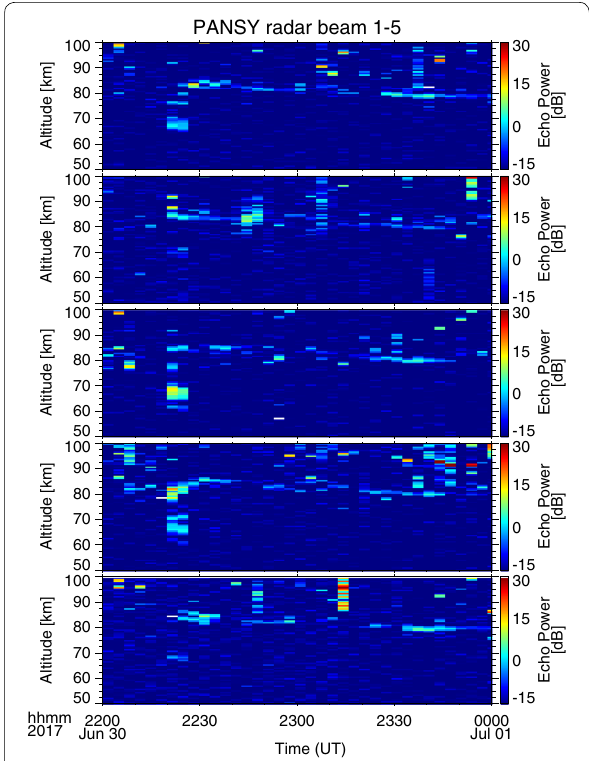
Fig. 2 Altitude profiles of the echo power enhancement as observed by the PANSY radar, Syowa Station. From top to bottom, the directions of the five beams are the zenith, north, east, south, and west, respectively, at a zenith angle of 10°. The beam width is ~ 1°. The altitude range resolution is 0.6 km, and the temporal resolution is ~ 4